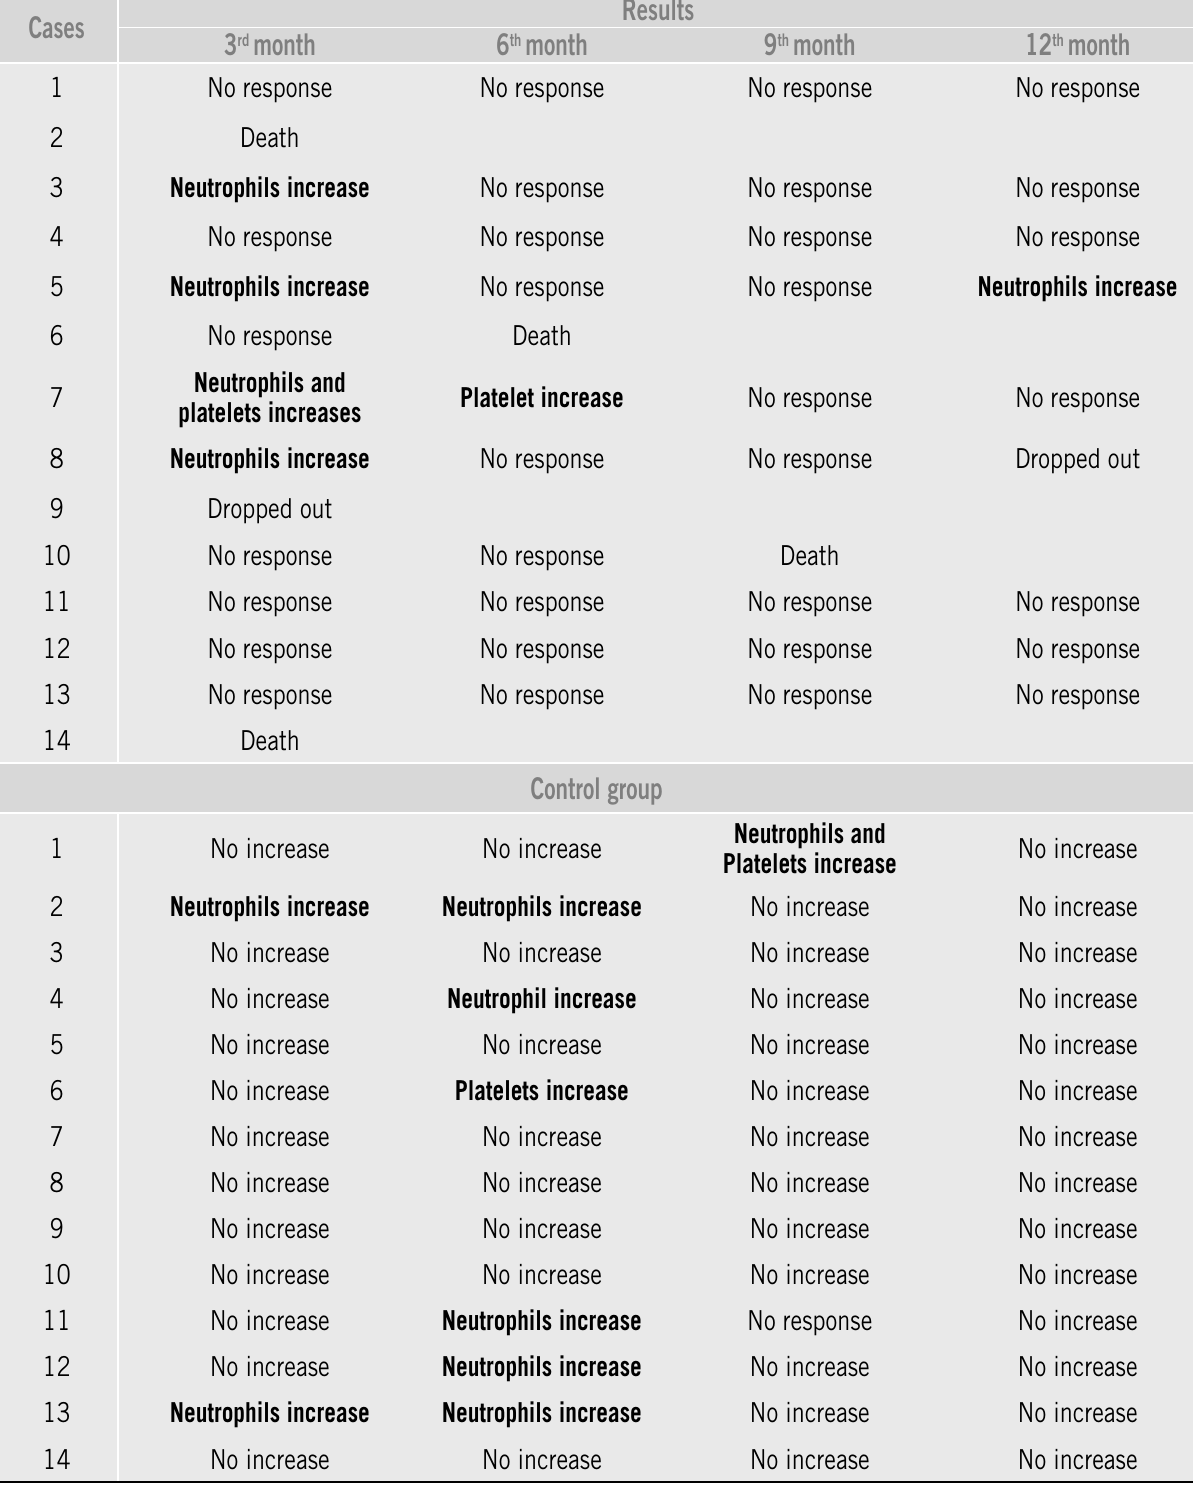
Table 2 Responses of all patients and controls during the study period